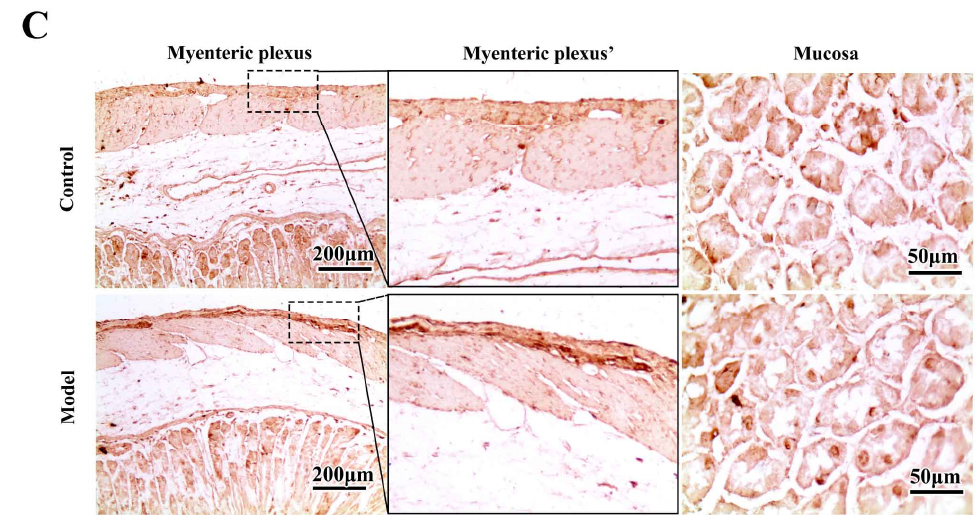
Figure 3. Synucleinopathy localization in the chronic MPTP/p-induced PD mouse stomach. ( A ) Representative photomicrographs of HE staining in stomachs across groups (scale bar = 200/100 μm). ( B ) Stomach sections from control and model mice were stained for oligomeric α-synuclein using the 5G4 antibody (scale bar = 200/100 μm). ( C ) Stomach sections from control and model mice were stained for nitrated α-synuclein using the anti-n-syn antibody (scale bar = 200/50 μm).